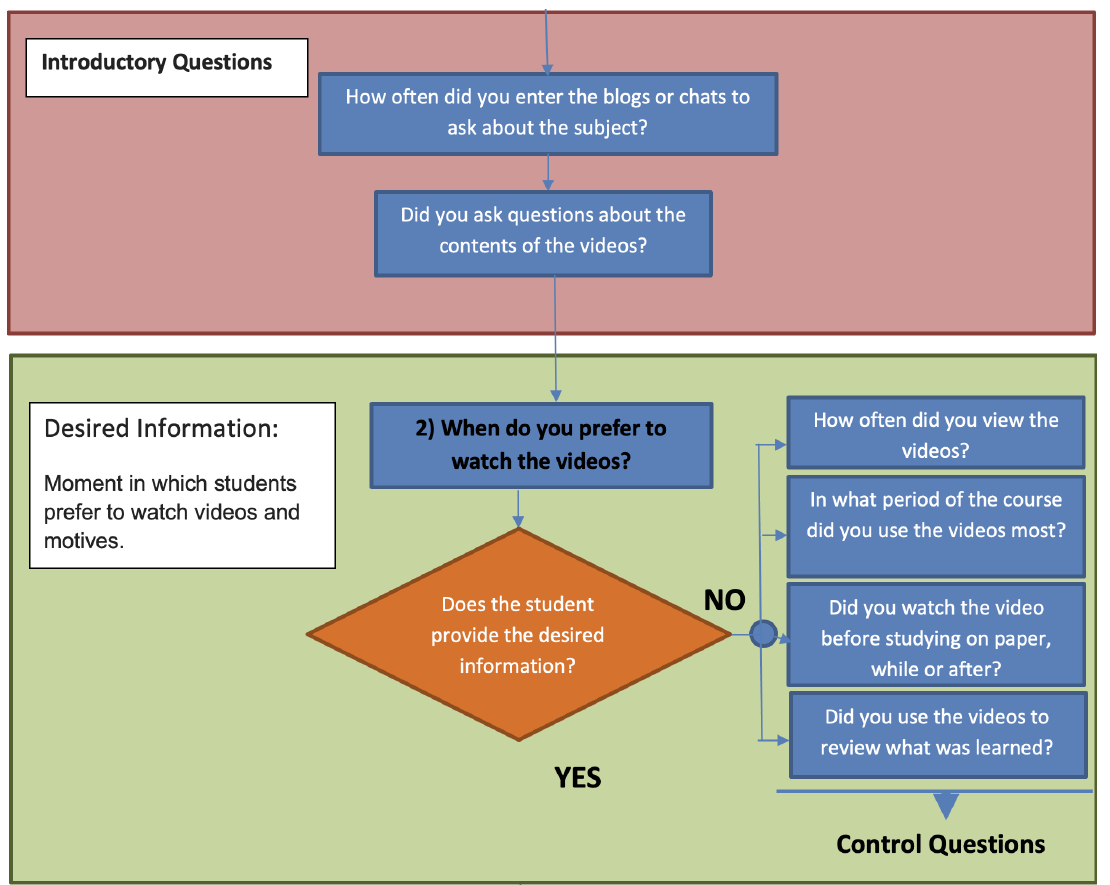
Figure A3. Structure of the interview (III)